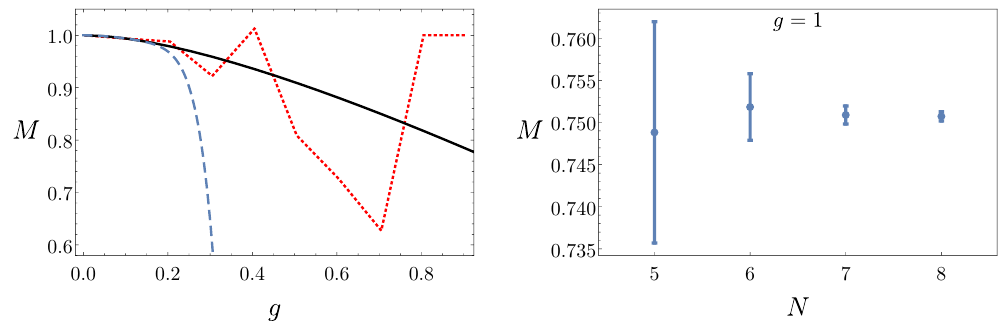
Figure 6 . (Left panel) The physical mass M as a function of the coupling constant g obtained by ordinary perturbation theory up to the g 8 order (blue dashed line), optimal truncation (red dotted line) and Borel resummation using conformal mapping (black solid line). Notice how optimal truncation gives accurate predictions up to g . 0 : 3, in contrast to blind perturbation theory that breaks down for smaller values of the coupling g . 0 : 15. Errors are not reported to avoid clutter. (Right panel) Central value and error of M ( g = 1) as a function of the number of loops N kept in the conformal mapping resummation